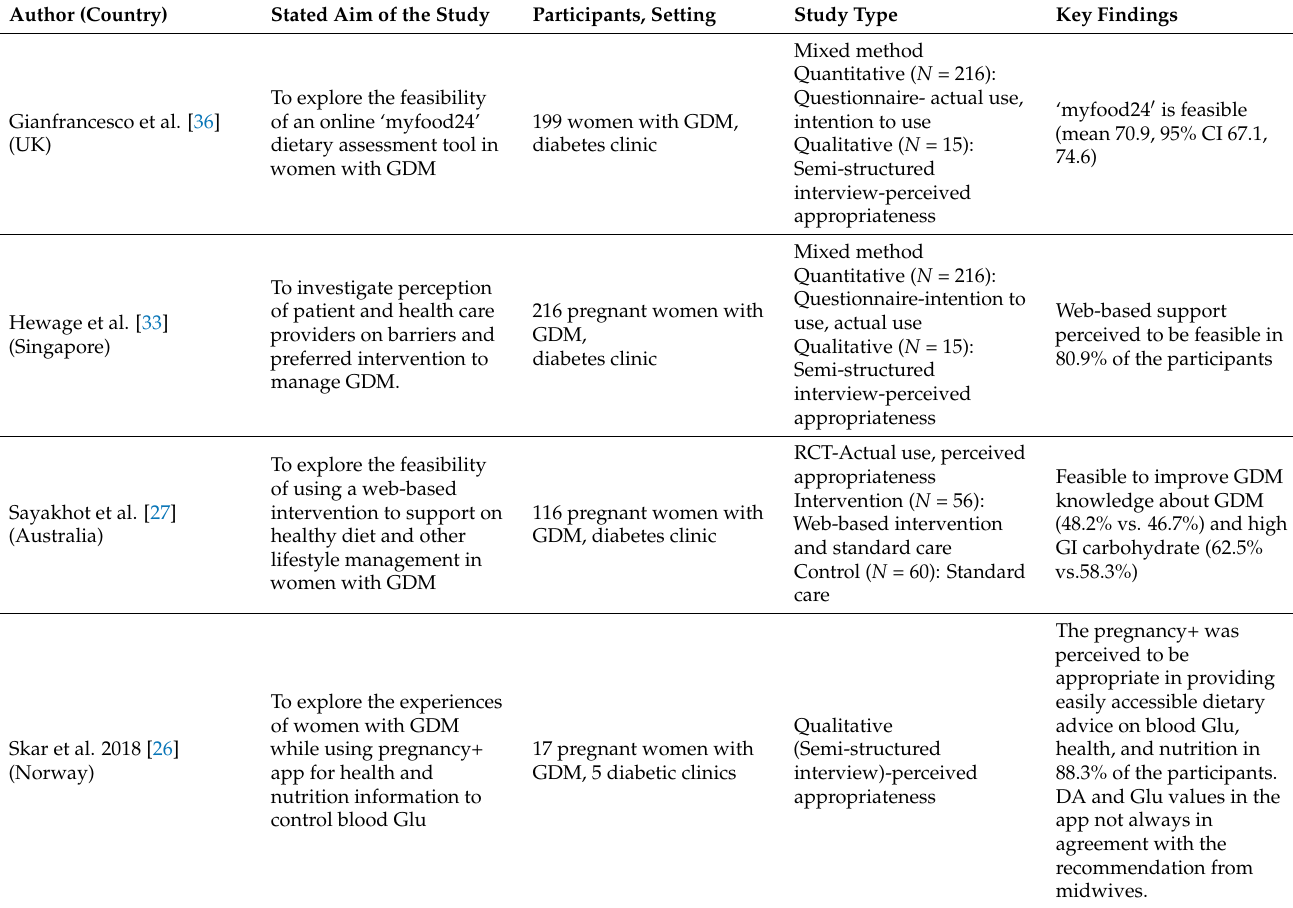
Table 5. Overview of studies reporting on the feasibility of digital tools to support dietary self- management of gestational diabetes